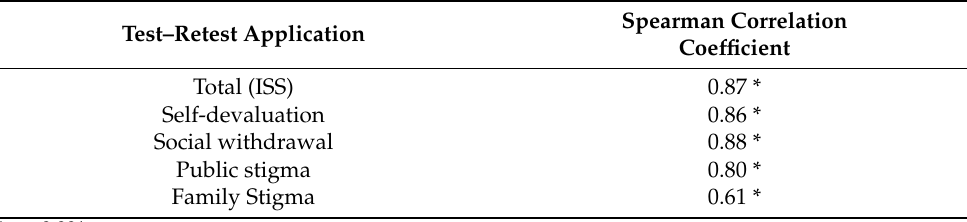
Table 5. ISS test–retest analysis ( N =